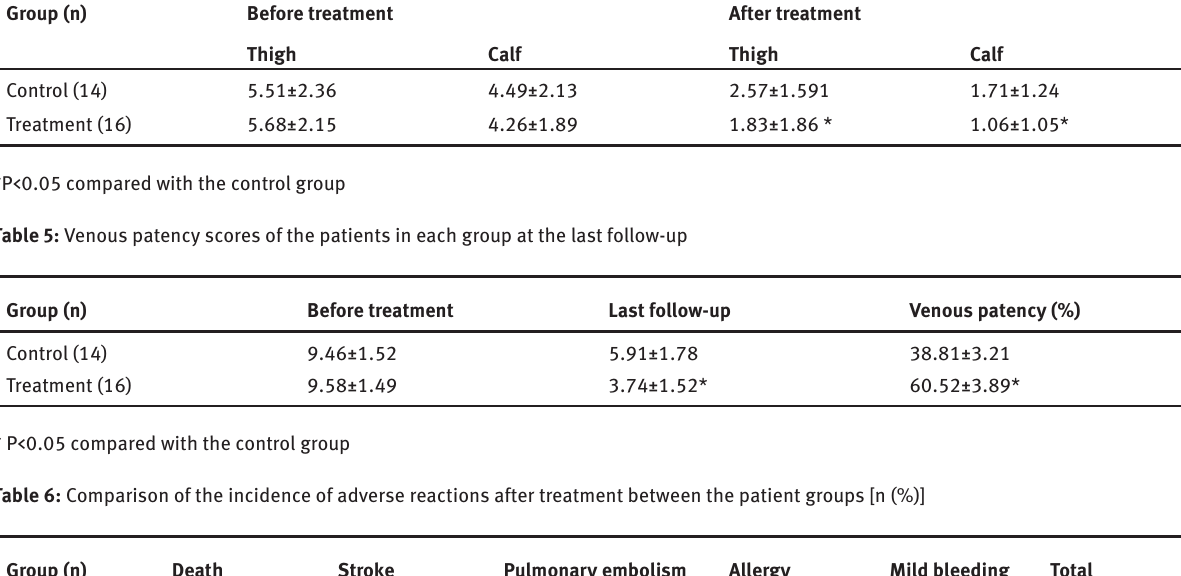
table in clinical practice, irrespective of the method used Table 4: Differences in the thigh and calf circumferences between the affected and non-affected limbs in the patient groups at the last follow-up Group (n)